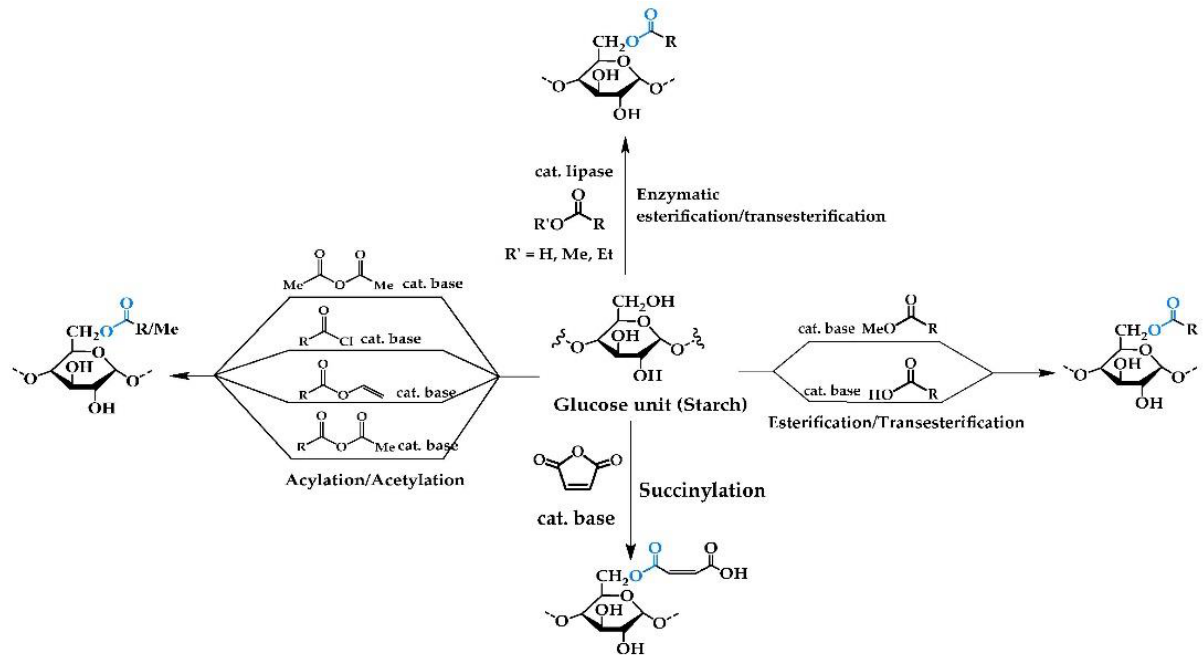
Figure 1. Chemical reactions for production of esterified